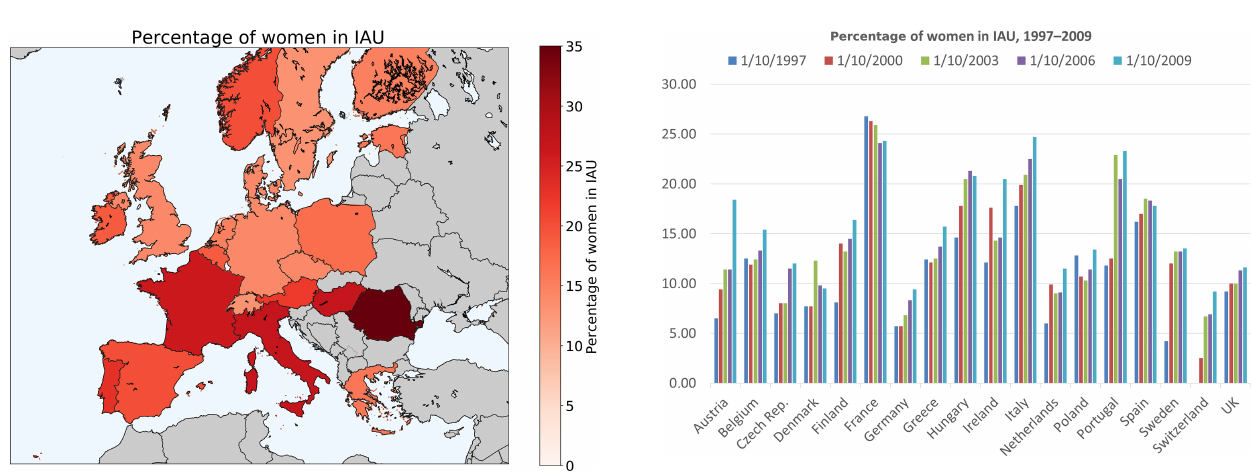
Figure 4. Percentage of women in the International Astronomical Union (IAU) from all ESA’s Member State. Colorbar indicates the percentage women for each country.